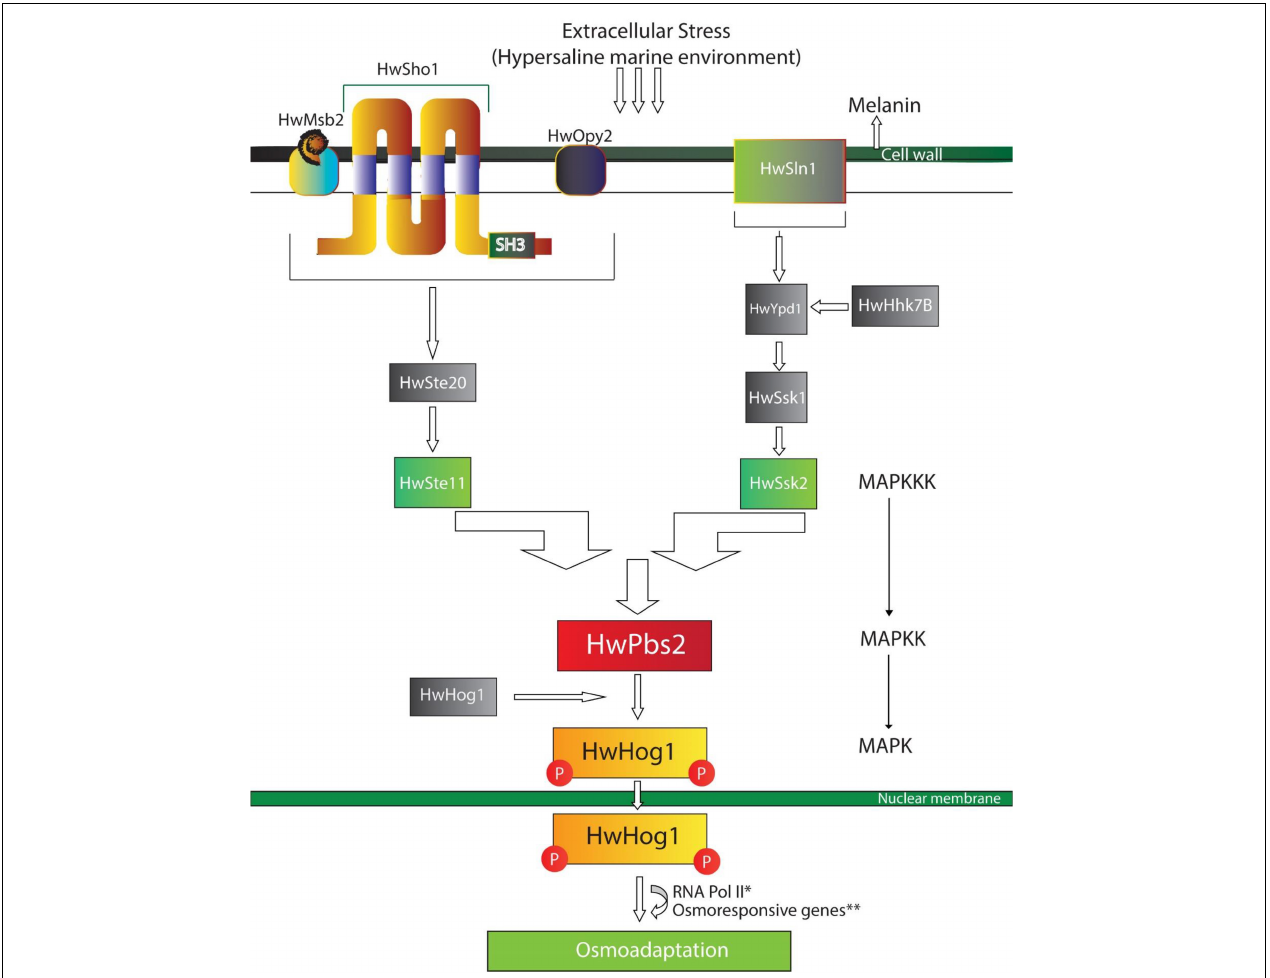
FIGURE 2 | A schematic model of HOG – signaling pathway in Hortaea werneckii . Here, HwSho1 along with HwMsb2 and HwOpy2 interact with external stimuli (changes in salinity and osmolarity) and transmits the signal to HwHog1 (MAPK) mediated pathway through HwSte11 (MAPKKK) and HwPbs2 (MAPKK). In H. werneckii , the phosphorelay (HwSln1-HwYpd1-HwSsk1) interacts with cytosolic histidine-kinase (Hwhhk7) to transmit the external signal to HwSsk2. Signals from both sensors (HwSho1 and HwSln1) converge at HwPsb2, HwPsb2 activates HwHog1. Activated HwHog1 translocates to the nucleus and interacts with osmoresponsive genes and RNA Pol II for adaptation in fluctuating and hyperosmotic environments. *May or may not interact, **genes responsible for glycerol production, protein synthesis, amino acid metabolism, lipid